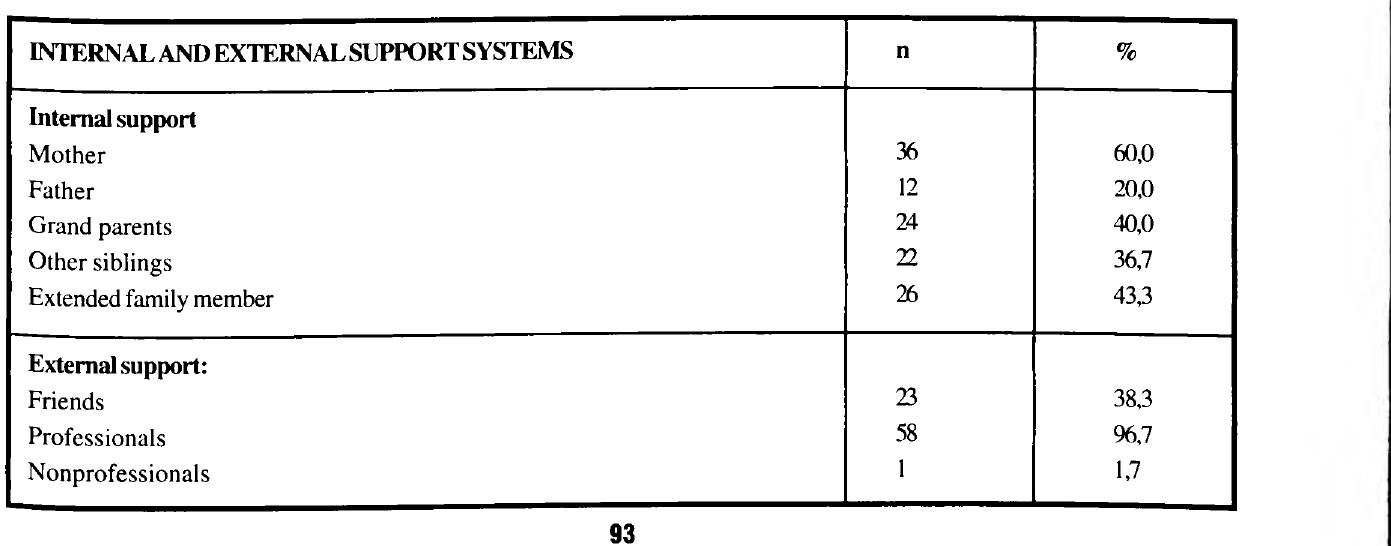
INTERNAL AND EXTERNAL SUPPORT